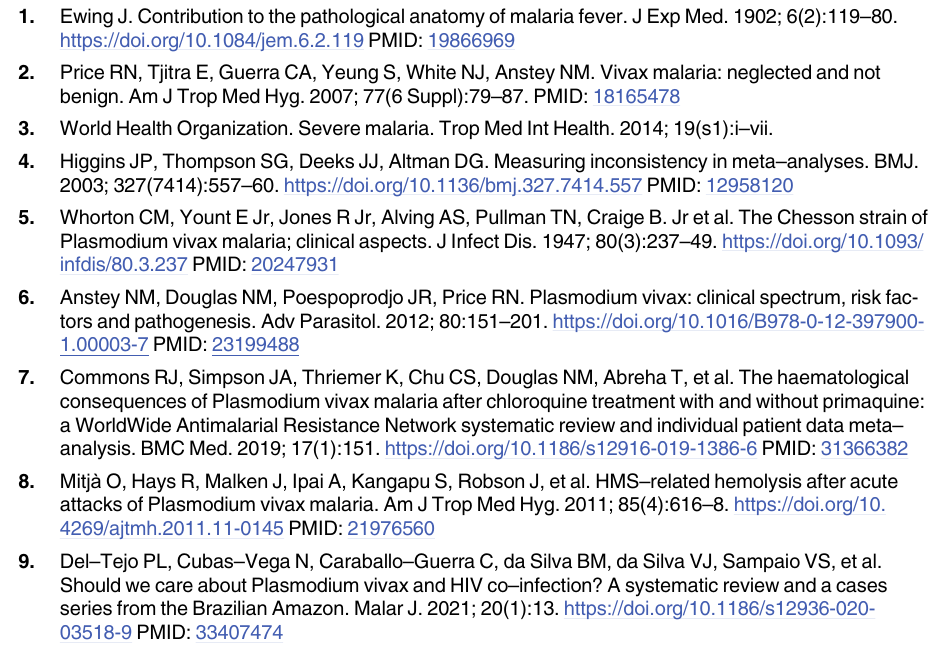
S2 Table. PRISMA checklist. PRISMA, Preferred Reporting Items for Systematic Reviews and Meta-Analyses. S3 Table. Summary of severe manifestations of vivax malaria. S4 Table. List of studies included in meta-analyses. S5 Table. Risk of bias assessment of studies in meta-analyses. S6 Table. Assessment of small study effects. S7 Table. Summary of studies of severe vivax malaria in pregnant women. S8 Table. Proportion of severe vivax stratified by settings within each region. S9 Table. Summary of renal biopsy histology from patients with vivax